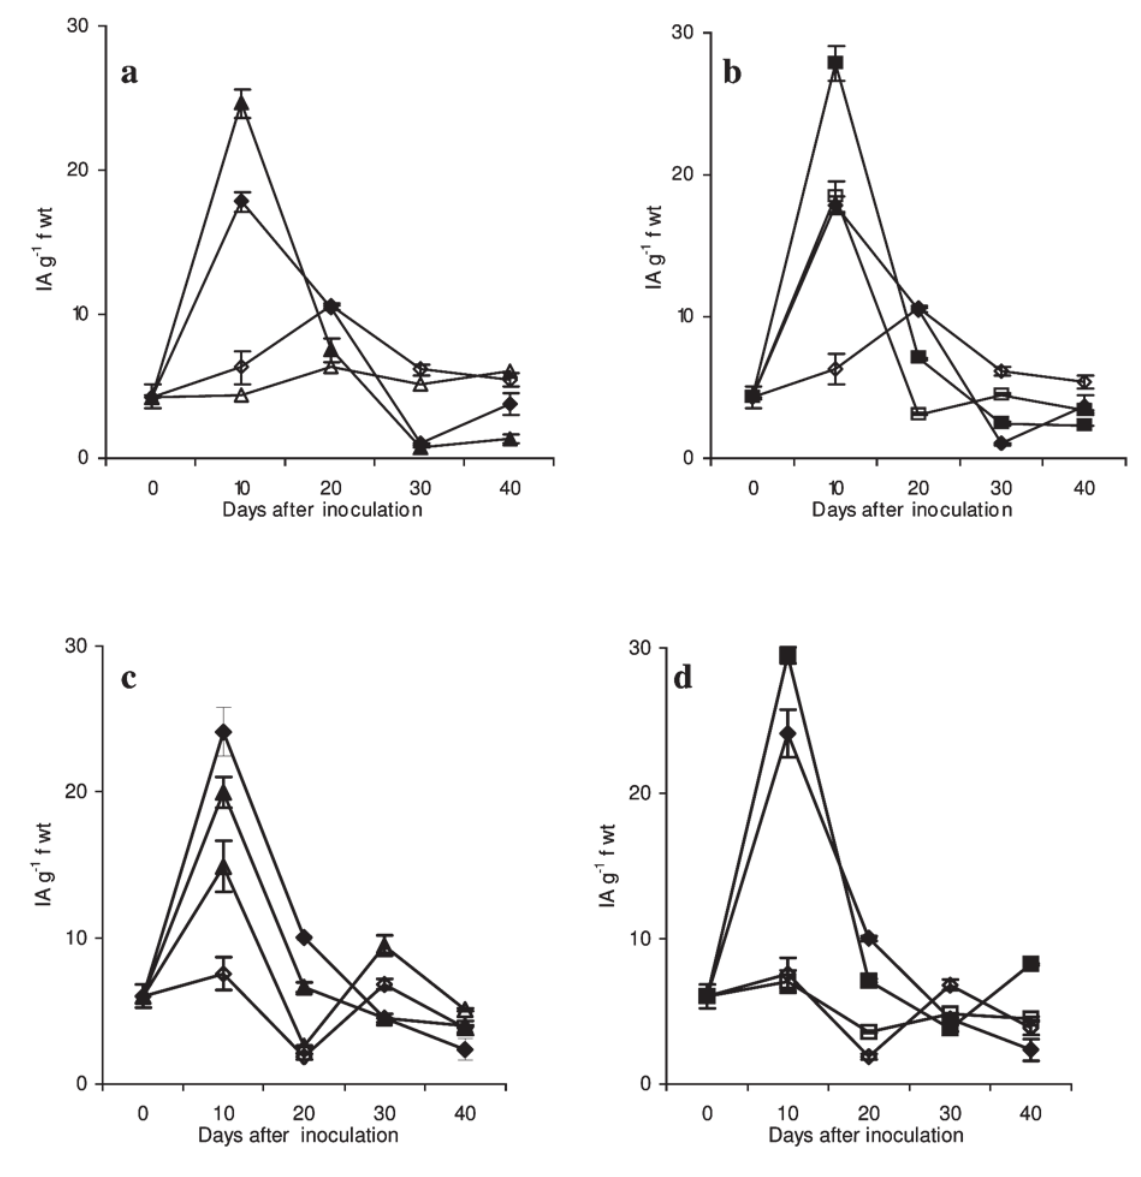
Fig. 3. Time-course diagram of formononetin levels in the roots of the susceptible chickpea cv. ILC482 (a and b) and the moderately resistant cv. INRAT87/1 (c and d) subjected to various treatments (- (cid:1) - water + water; - (cid:2) - Rhizobium isolate PchDMS + water; - (cid:1) - Rhizobium isolate Pch43 + water; - (cid:3) - Water + Foc; - (cid:4) - PchDMS + Foc; - (cid:5) - Pch43 +